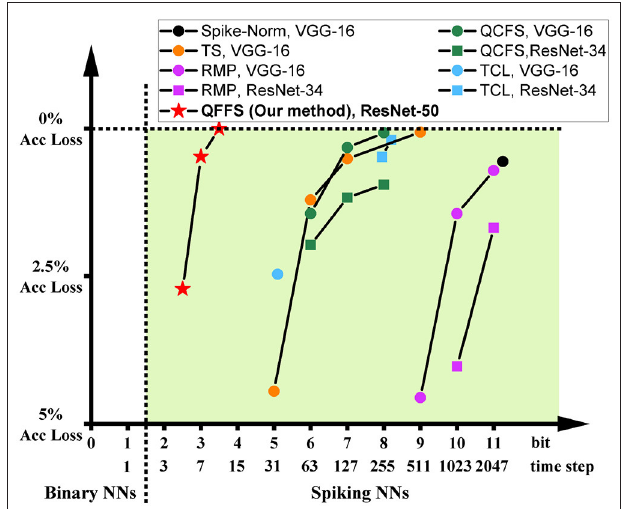
FIGURE 5 | The relationship between ANN-to-SNN conversion loss and SNN inference latency on ImageNet.